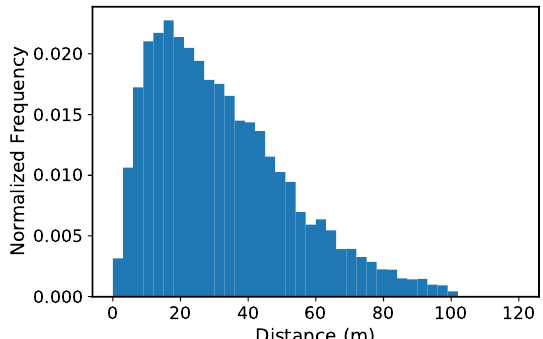
Figure 2. Histogram of distances between pedestrians and cameras.